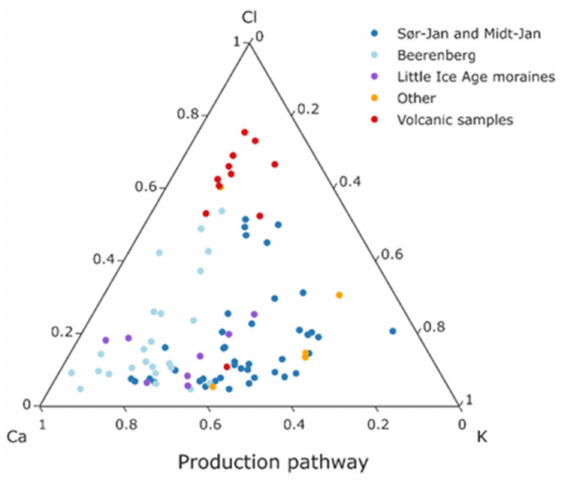
Figure 6. Ternary plot indicating the contributions from each major production pathway. The samples have been normalized so that the Ca production + K production + Cl production = 100%. The colors indicate sample region (the same colors as in Figure